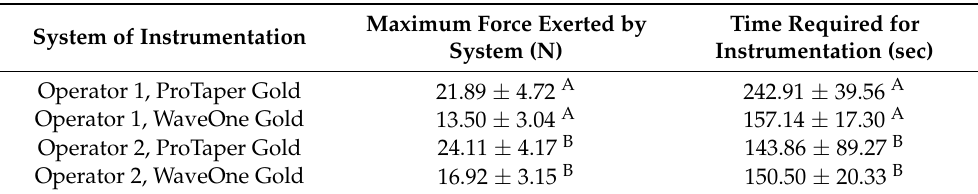
Table A1. Comparison of operator performance through maximum exerted forces and time required for system instrumentation. Common superscript letters indicate significance (Read vertically).